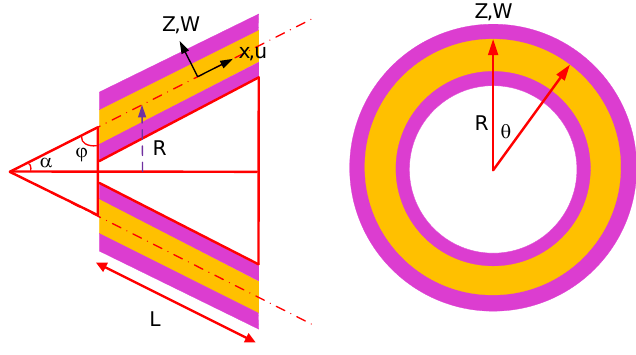
Figure 1. Schematic representation of conical